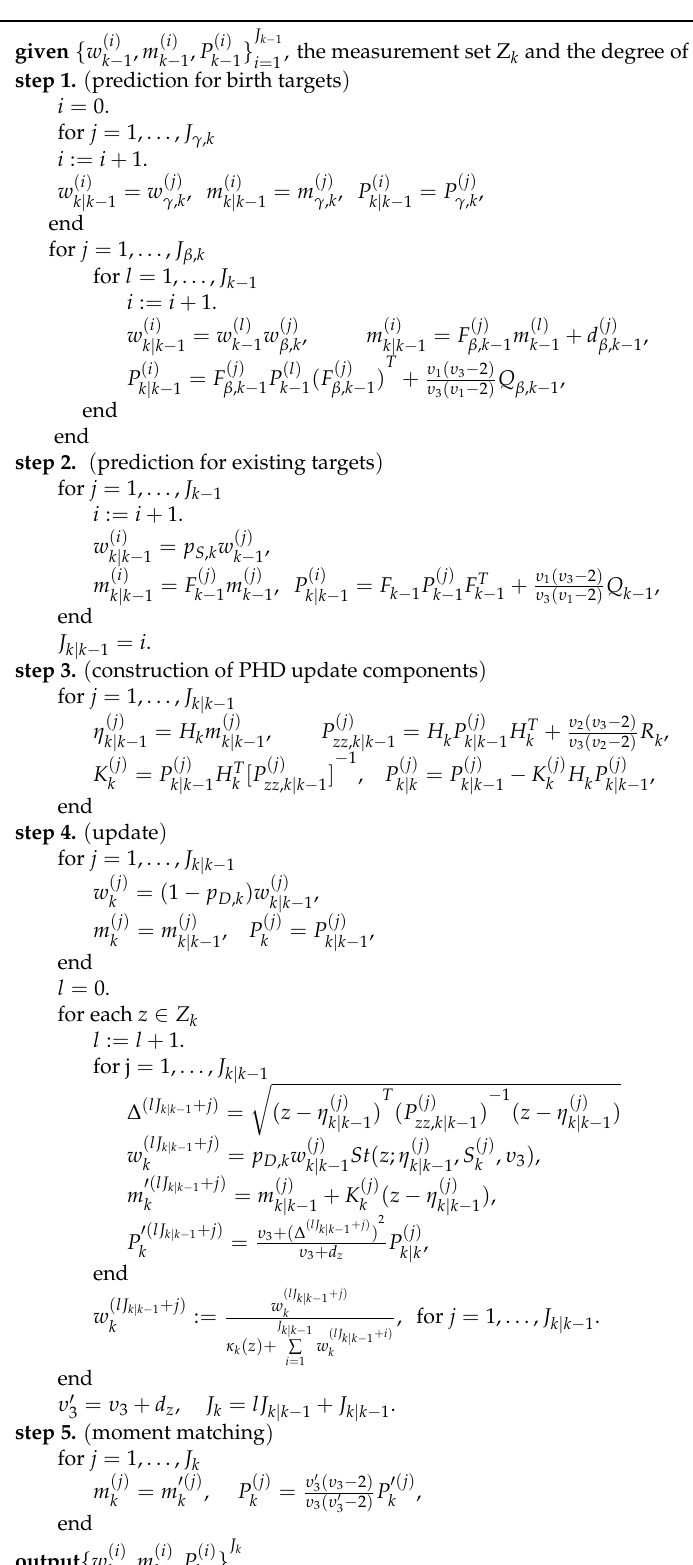
Table A1. Pseudocode for the STM-PHD